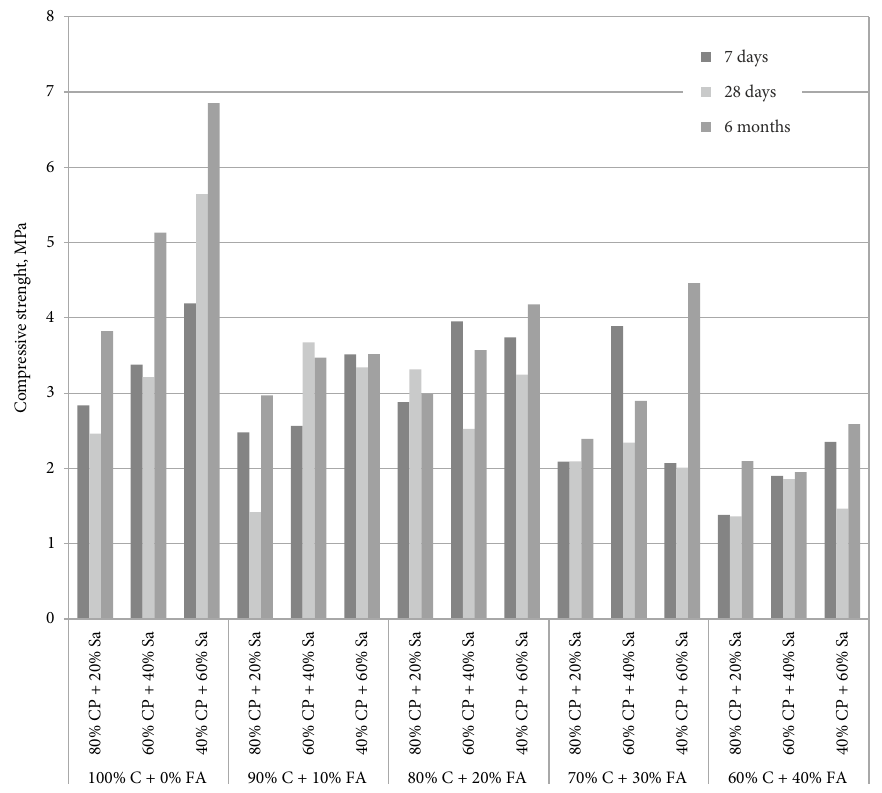
Figure 10. Compressive strength summary